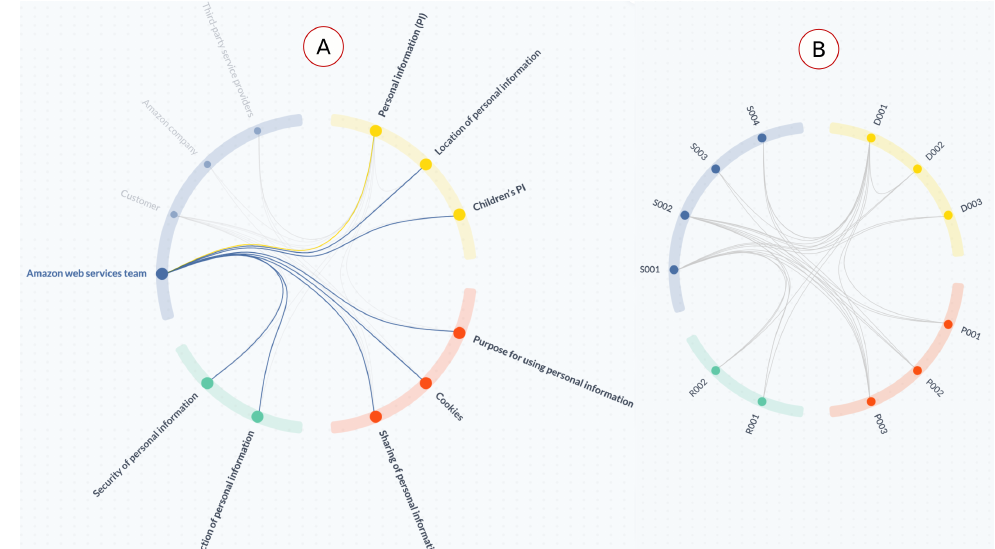
Figure 6. Full text representation ( A ) and ID representation ( B